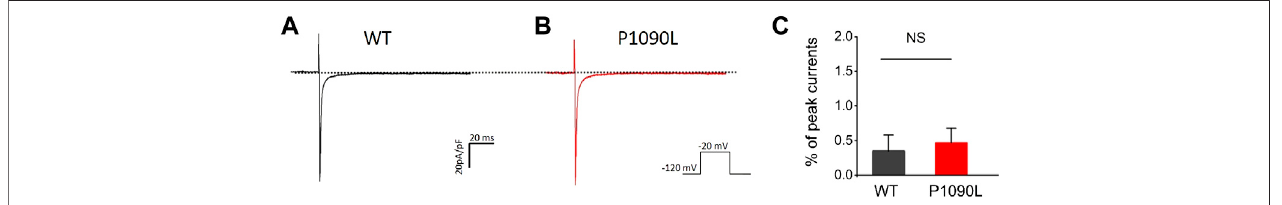
FIGURE4| P1090LmutationdoesnotincreasethelatesodiumcurrentsoftheNa v 1.5channel. (A,B) :Representativewild-type(WT) (A) andP1090L (B) persistent sodium current traces. Currents were activated by depolarization to − 20 mV from a holding potential of − 120 mV, and the dash line represented 0 pA. (C) . The late sodium currents were measured and normalized to peak currents, n = 6 cells in each group, data are presented as the mean ± SEM. NS, non-signi fi cant.